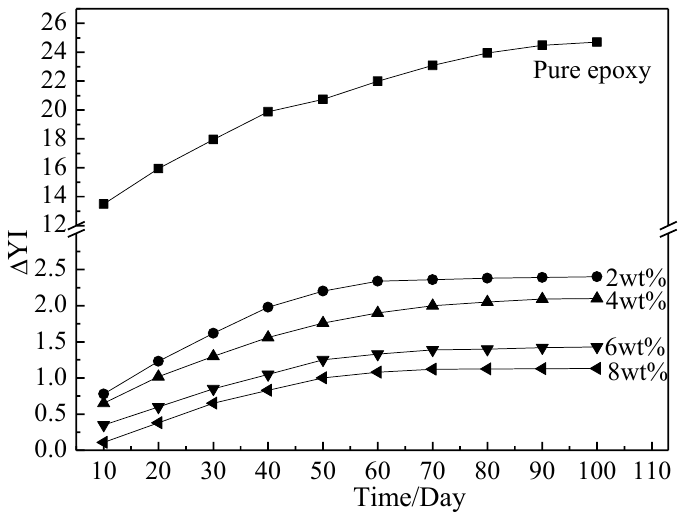
Figure 4. The cha nges to ΔY I over time of the pure epoxy and composites. Figure 4. The changes to ∆ YI over time of the pure epoxy and composites.